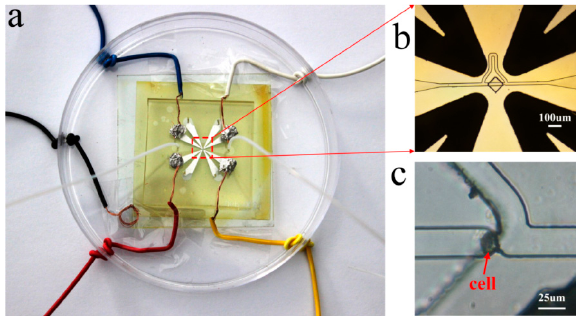
Figure 9. ( a ) The biochip platform. The biochip is connected to the cell buffer solution medium and electrical connections are wired from the electrodes to the external potential supply of ac signals. ( b ) Close-up view of the electrodes and channel. ( c ) Snapshot of one captured cell in the trap site.